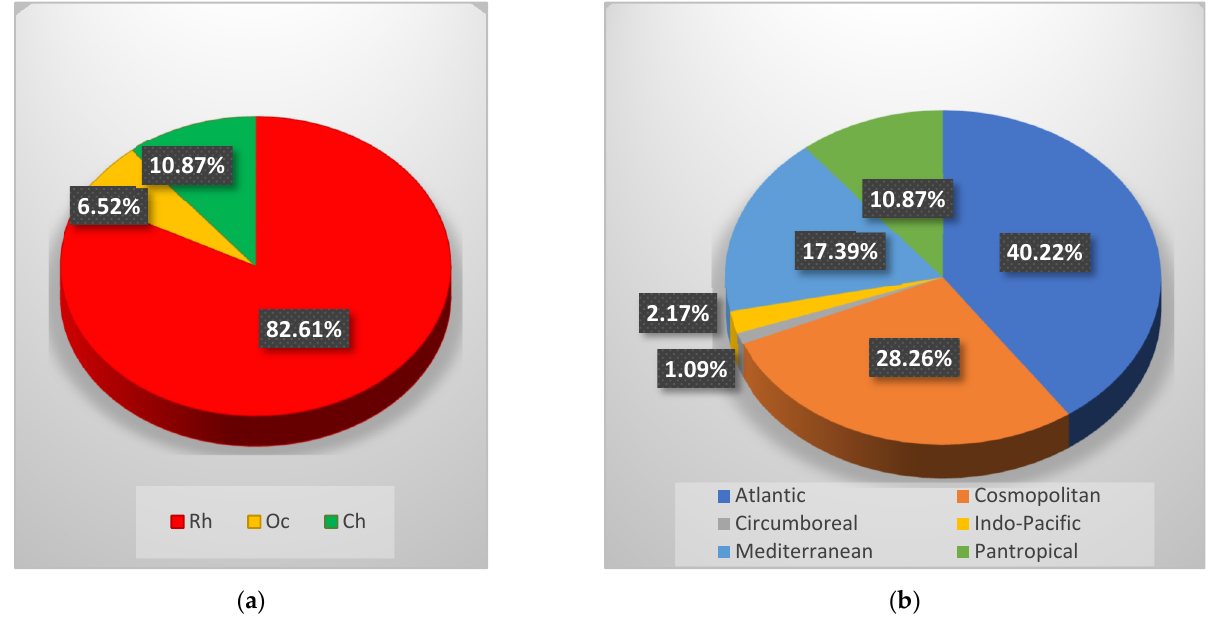
Figure 2. ( a ) Percent incidence of Rhodophyta (Rh), Ochrophyta (Oc), and Chlorophyta (Ch) of the coralligenous flora recorded in 2019; ( b ) Chorological spectrum of the coralligenous macroalgal assemblages recorded in 2019.